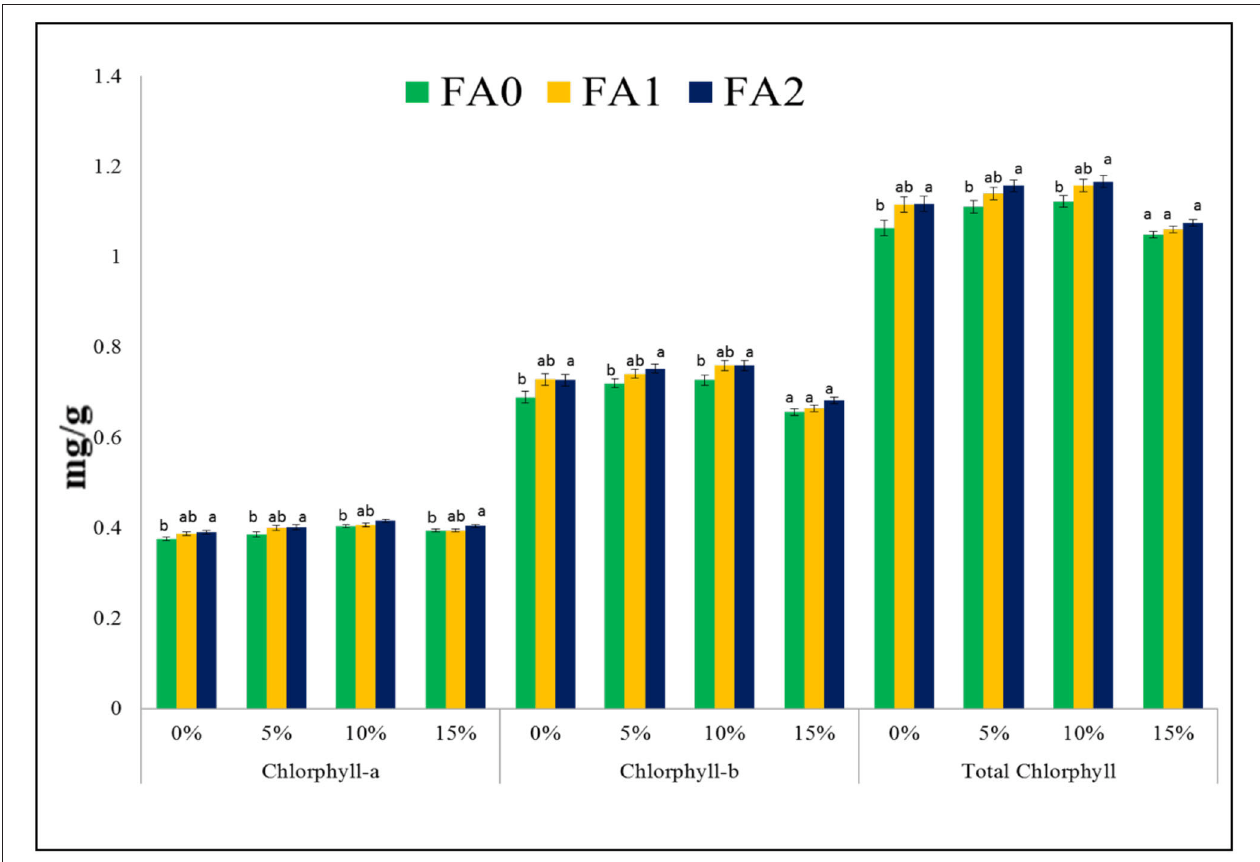
FIGURE 4 | Chlorophyll content at various treatment levels of FA (0, 10, and 20%; F0, F1, and F2) of Brassica napus L. grown at different concentrations of soil amended with paper sludge.